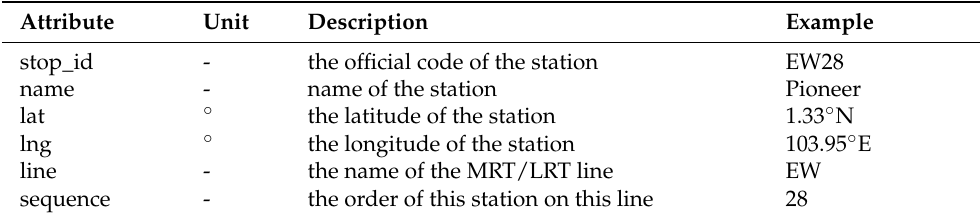
Table 8. Attribute list of the subway system data.